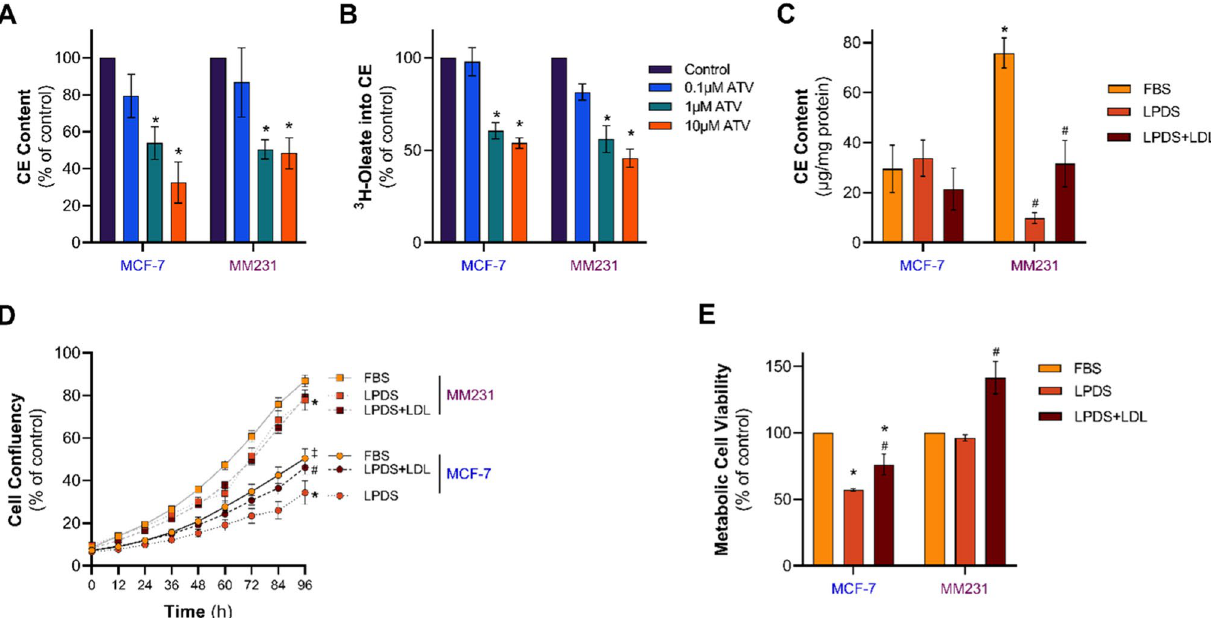
Fig. 4 Cholesterol metabolism in MCF-7 and MDA-MB-231 cells in response to ATV treatment or cultured in modified media. MCF-7 and MDA-MB-231 (MM231) cell A cholesteryl ester (CE) content and B CE synthesis determined by 3 H-oleate incorporation into CE following culturing in DMEM containing 10% FBS either with vehicle control (0.1% DMSO) or ATV (0.1, 1 or 10 µM) for 48 h. MCF-7 and MM231 cell ( C ) CE content ( D ) proliferation by IncuCyte and ( E ) metabolic viability by MTT following culturing in DMEM containing 10% FBS, 10% LPDS or LPDS loaded with 50 µg/ml of human LDL. Data are mean ± SEM of at least three independent experiments performed in triplicate ( A – C ), quadruplicate ( E ) or with six technical replicates ( D ). *p < 0.05 vs. Control (vehicle-treated cells) within each experiment; #p < 0.05 vs. LPDS; ‡p < 0.05 vs. MM231 by one-way ANOVA followed by Dunnett’s post hoc test (A&B) or two-way ANOVA followed by Tukey’s post hoc test ( C – E